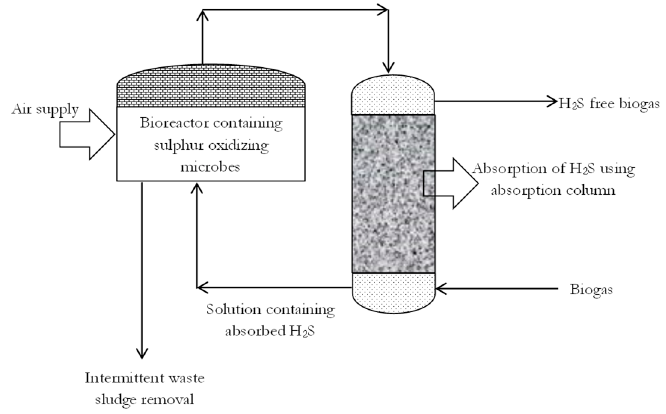
Figure 3. Simple illustration of a bioscrubber highlighting the two steps of initial H 2 S absorption followed by H 2 S oxidation.